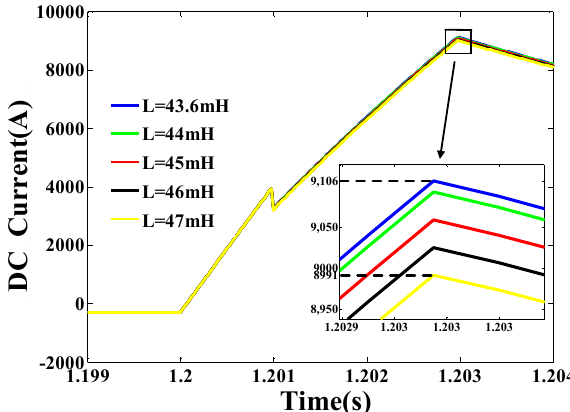
Figure 18. Simulation results of the controlled R FCL and di ff erent L FCL . Table 3. Arm currents under the calculated and simulated 𝐿 (cid:3007)(cid:3004)(cid:3013)_(cid:3040)(cid:3036)(cid:3041) .